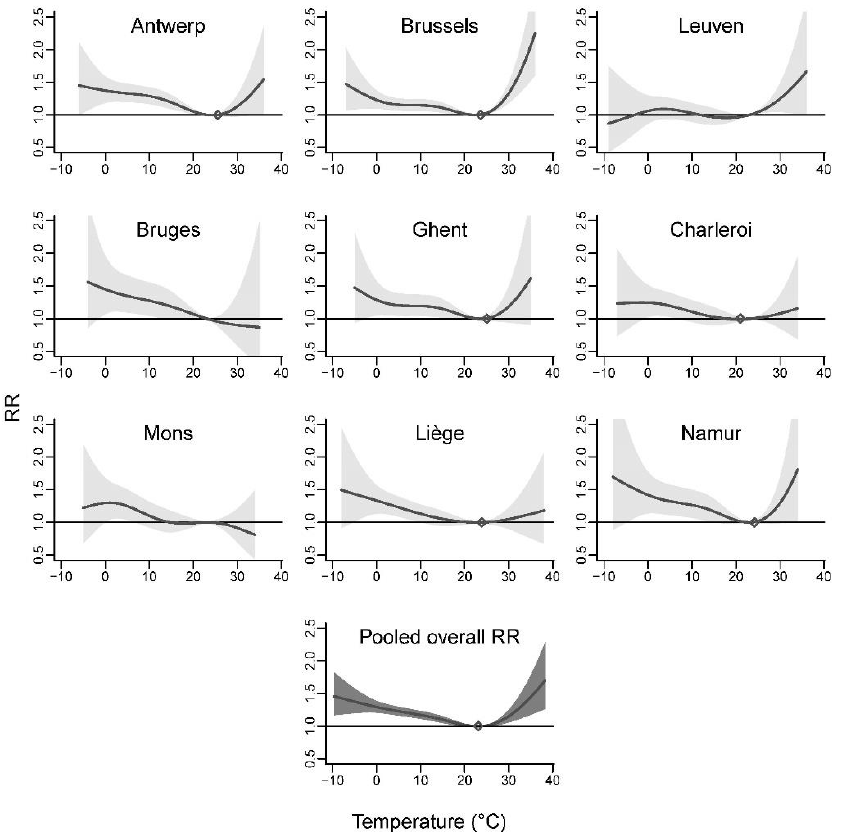
Figure 1. Agglomeration-specific and pooled overall temperature–mortality associations cumulated over lags of 0–21 days, 2010–2015.